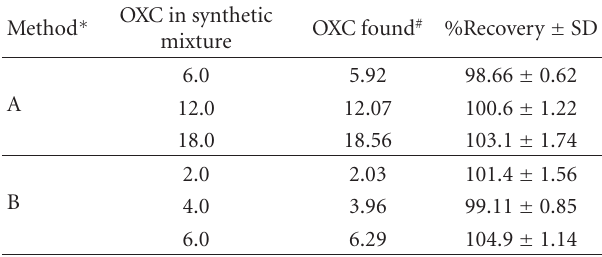
Table 2: Results obtained for the study of e ff ect of matrix by the analysis of synthetic